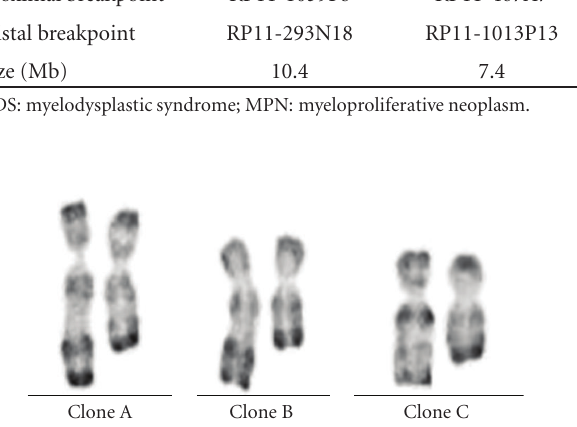
Table 2: Size and boundaries of commonly deleted regions in del(20q) and ider(20q) patients.